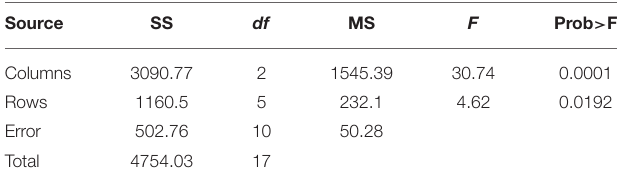
TABLE 5 | ANOVA for the effect of silver nanogel on burn wound model in albino Wistar rats.